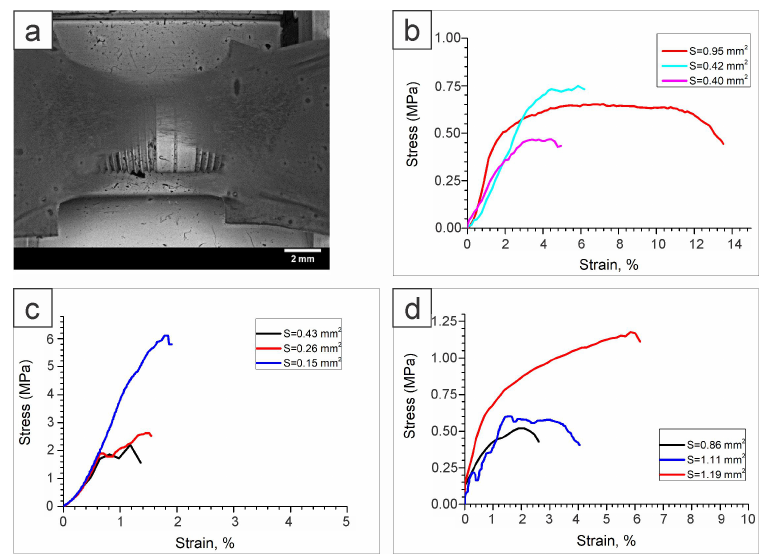
Figure A1. Core–shell fiber mat mounted in the Deben device ( a ); stress–strain curves with the cross-sectional areas of fibers: PVA-GO shell ( b ); PVA-PEG-SiO 2 core ( c ); PVA-PEG-SiO 2 @PVA-GO core–shell ( d